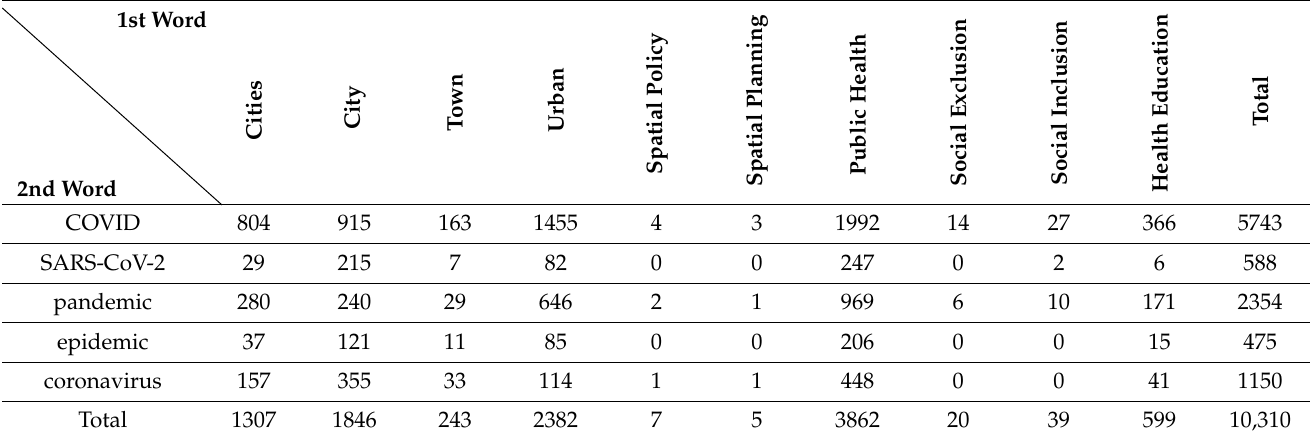
Table 1. Number of publications obtained based on keyword